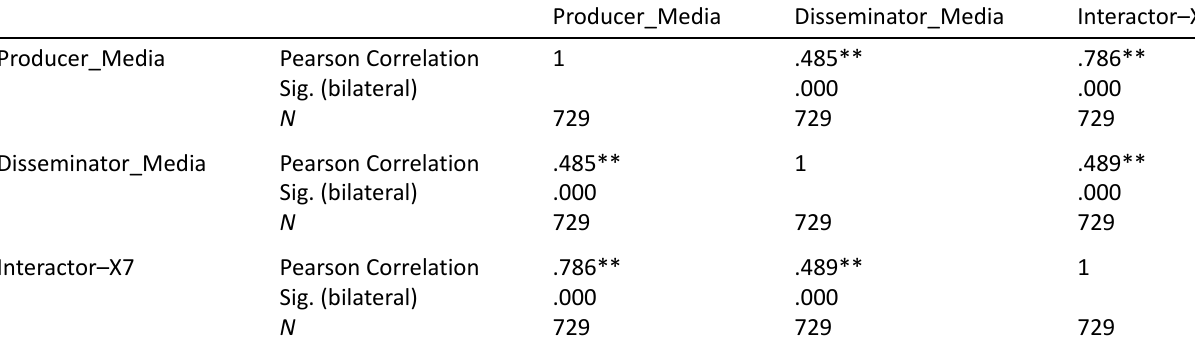
Table 9. Correlation analysis (producer, disseminator, and